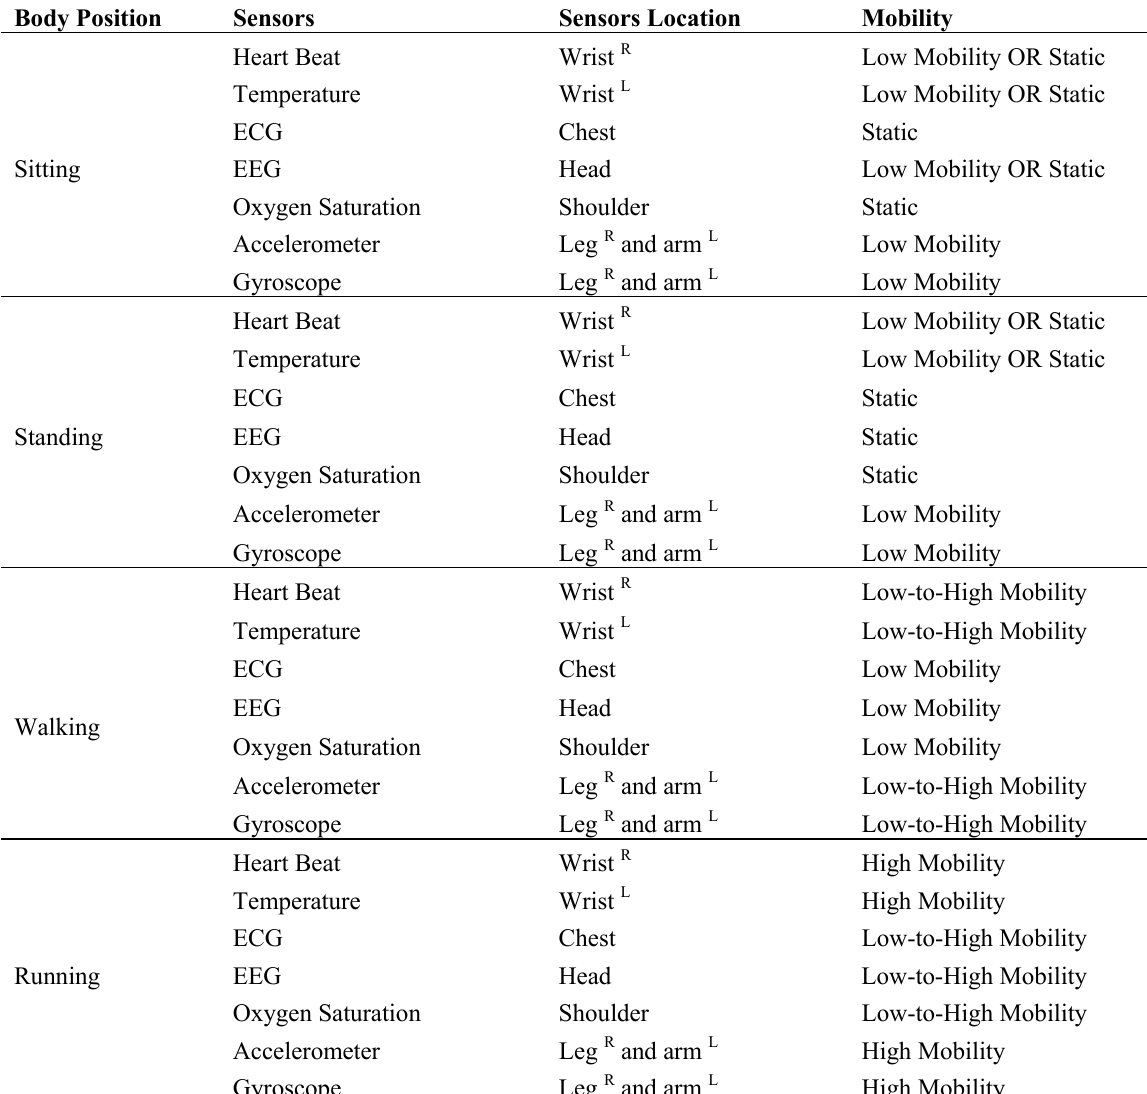
Table 16. Sensors, their locations and corresponding mobility for various body postures. R and L in the superscript (of sensor location) represent right and